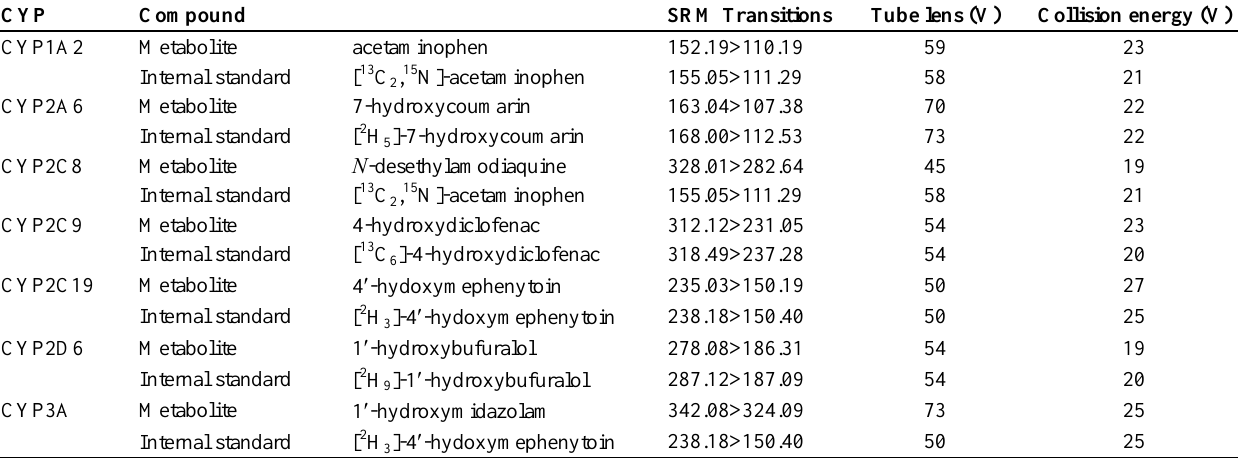
Table 3. LC/MS/MS measurement conditions for drug oxidation catalyzed by human